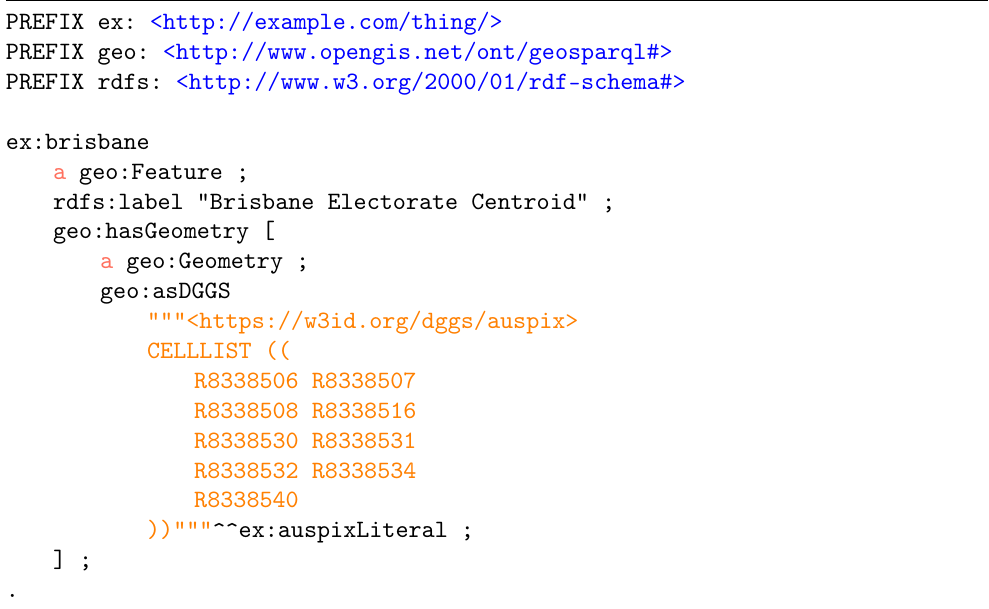
Figure 3. The generic predicate for indicating a DGGS serialization— geo:asDGGS —is used and the specific DGGS— AusPIX —is indicated via use of a custom datatype ex:auspixLiteral